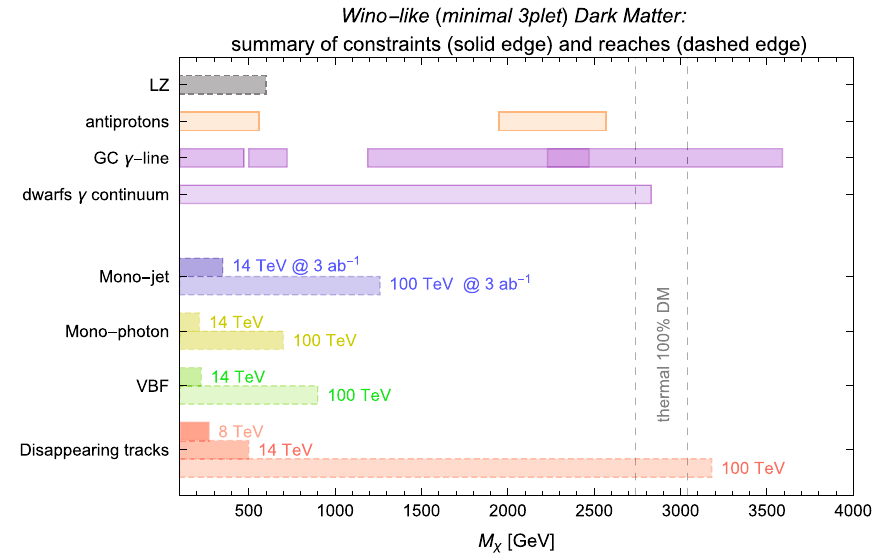
Fig. 12.1 Complementarity of different search strategies for Wino DM, with reach adapted from [339]. The top line ‘LZ’ shows projected direct detection reach, which is far from the mass range motivated by the relic abundance. Below that are the indirect detection constraints, which are subject to astrophysical uncertainties. For instance, in the galactic centre (GC) constraint the lighter and darker shading show lim-